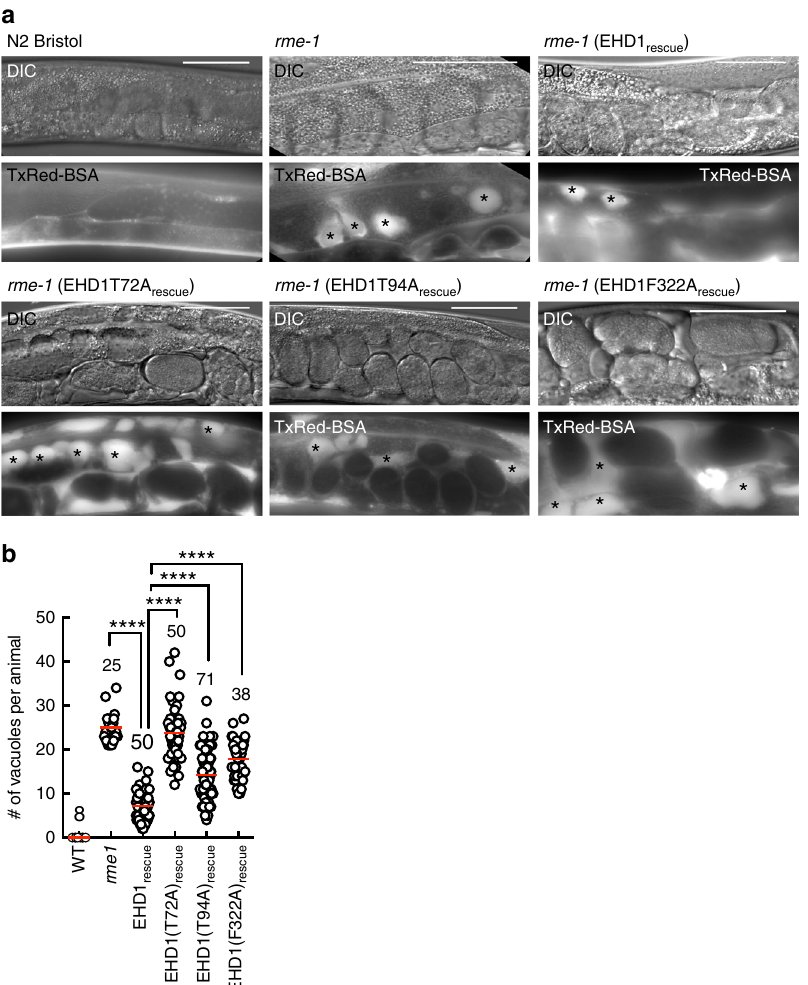
Fig. 1 Functional determinants in EHD1 required for endocytic recycling. a Representative DIC and fl uorescence images of worms injected with fl uorescent BSA. Asterisks mark vacuoles. Scale bars = 50 μ m. b Plot showing vacuole numbers per worm for the indicated numbers of worms. Red line denotes the mean. Statistical signi fi cance was assessed using an unpaired two-tailed t -test and **** P <